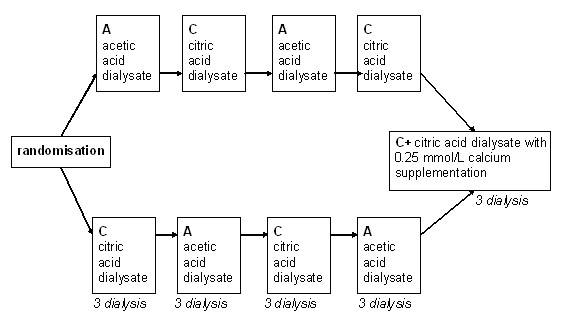
Study design. Schematic representation of the study design.